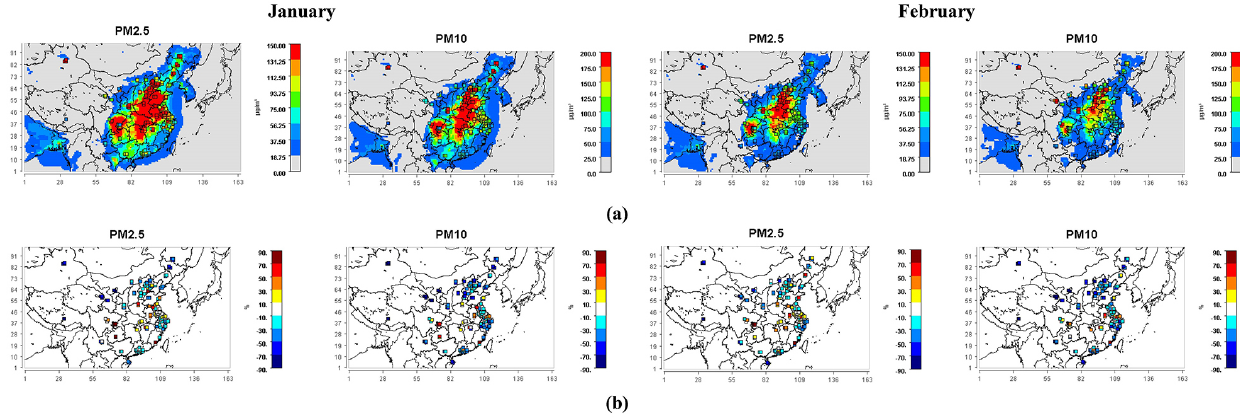
Fig. 4. (a) Overlay of the simulated and observed monthly average concentrations of PM 2 . 5 and PM 10 of the reported 74 cities and (b) the corresponding spatial distributions of NMBs for PM 2 . 5 and PM 10 at 36km horizontal grid resolution for January and February, 2013. Note the average for January is calculated from 14 January to 31 January due to the lack of data in 1–13 January. Square signs indicate the